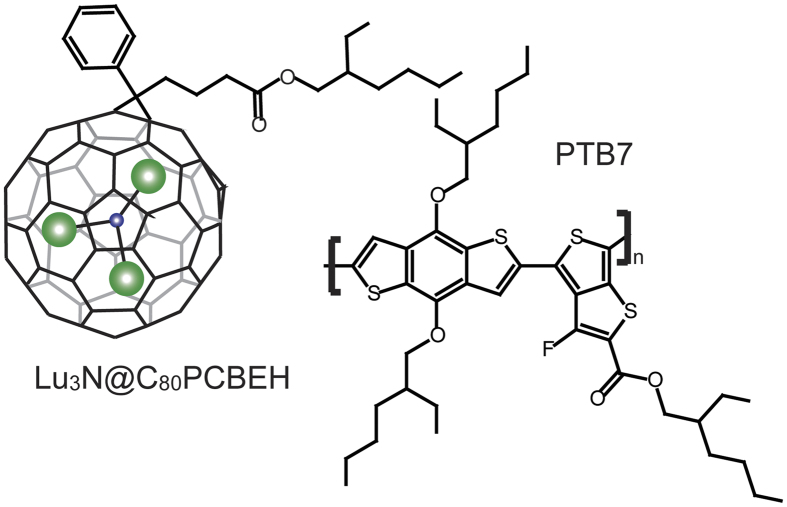
Molecular structures of PTB7 and Lu3N@C80-PCBEH.